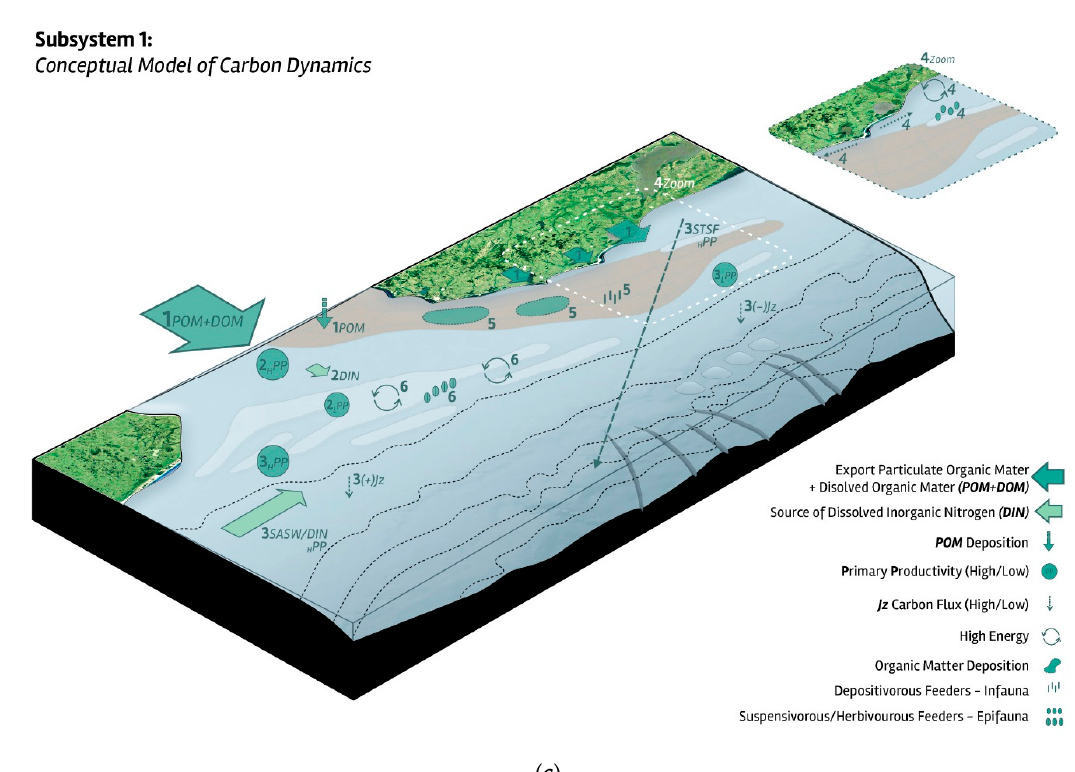
Figure 6. ( a ): Conceptual hydrodynamical process model (subsystem 1; continental shelf 0–180 m). Subantarctic Shelf Water (SASW), Subtropical Shelf Water (STSW), Subtropical Shelf Front (STSF), Río de la Plata (RdlP), Río de la Plata Plume (RPP), submarine groundwater discharge (SGD), oceanic exportation water (OEW). ( b ): Conceptual model of sediment dynamics (subsystem 1; continental shelf 0–180 m). Río de la Plata (RdlP), Río de la Plata Plume suspended sediment (RPPs), Río de la Plata Plume water (RPPw). ( c ): Conceptual model of carbon dynamics (subsystem 1; continental shelf 0–18 0m). Subantarctic Shelf Water (SASW), Subtropical Shelf Front (STSW).